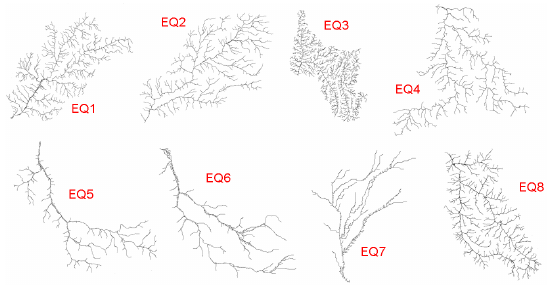
Figure A2. Drainage networks extracted from Elqui basin.